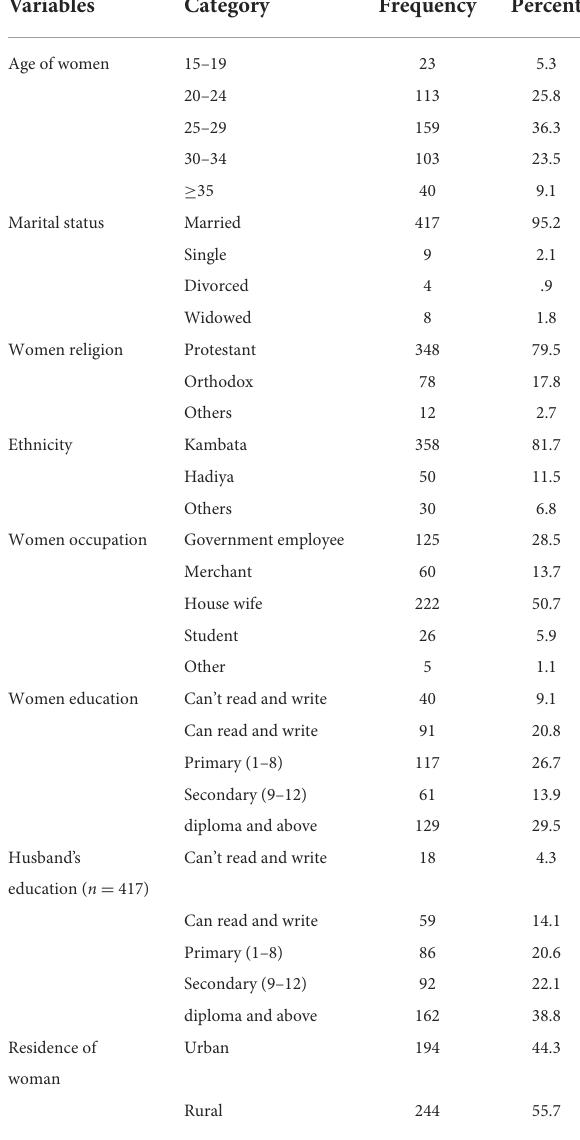
TABLE 1 Socio-demographic characteristics of Implanon user women visiting public health facilities to discontinue Implanon in Kembata Tambaro zone, South Ethiopia, 2020 ( n =